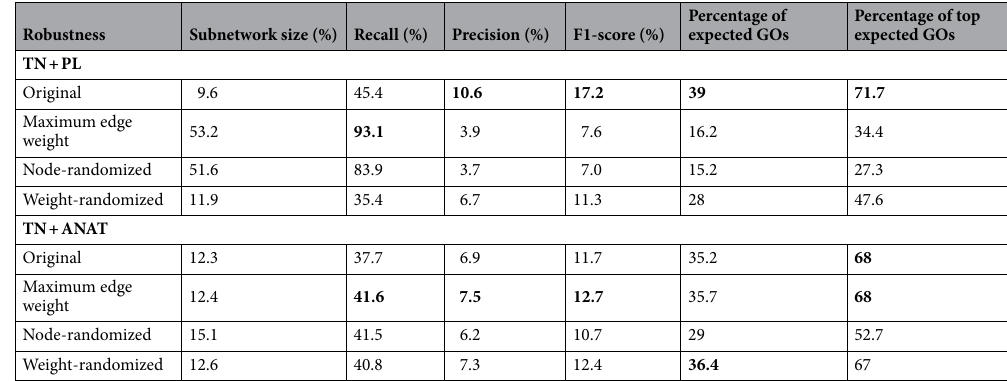
Table 1. Efficiency and robustness of TimeNexus-based active subnetwork extraction with PathLinker and the ANAT server over the entire tMLN. TN + PL: TimeNexus in combination with PathLinker; TN + ANAT: TimeNexus in combination with the ANAT server. Bold letters indicate the best performance in the respective comparison and category. Subnetwork size is calculated as the percentage of nodes retained in the extracted subnetwork from the full interactome, Recall represents the correctly retrieved cell cycle genes, Precision the percentage of cell cycle genes relative to the entire extracted subnetwork and the F1-score the overall accuracy. The percentage of expected GO terms is calculated based on the GO term enrichments of the 130 cell cycle genes (as defined by KEGG) alone, for the percentage of top expected GO terms, we only consider the first quartile